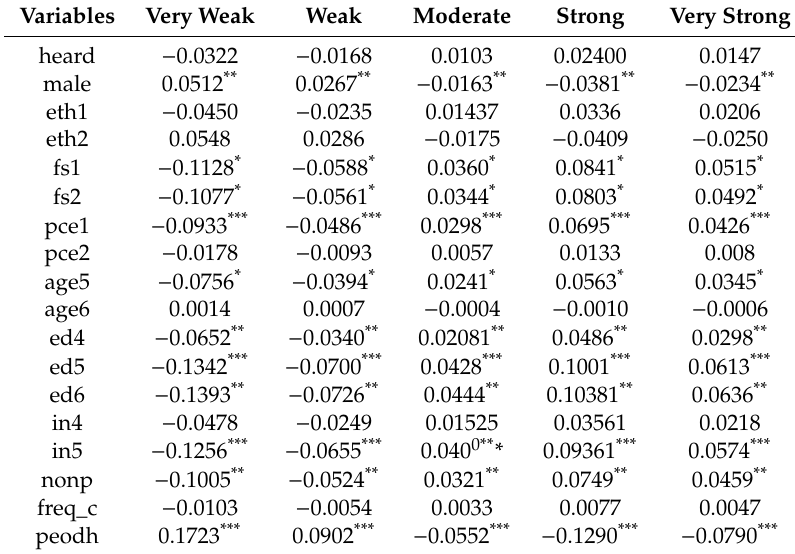
Table 5. Marginal e ff